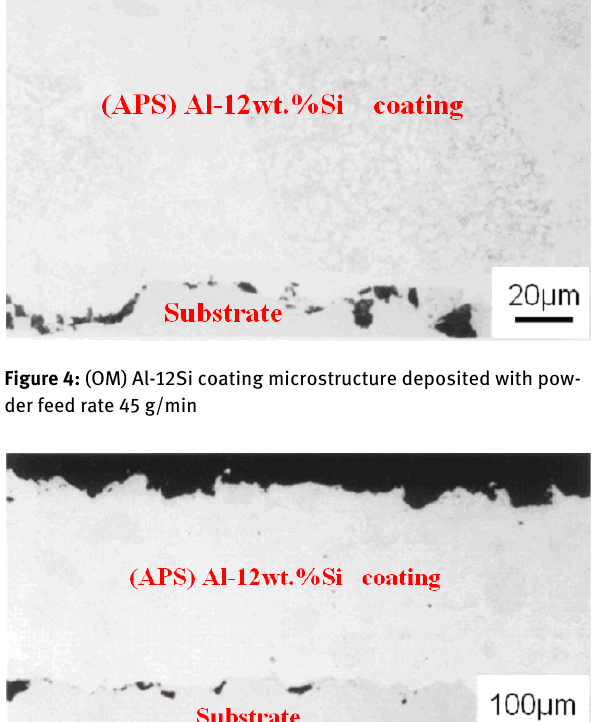
Figure 5: (OM) Al-12Si coating microstructure deposited with powder feed rate 45